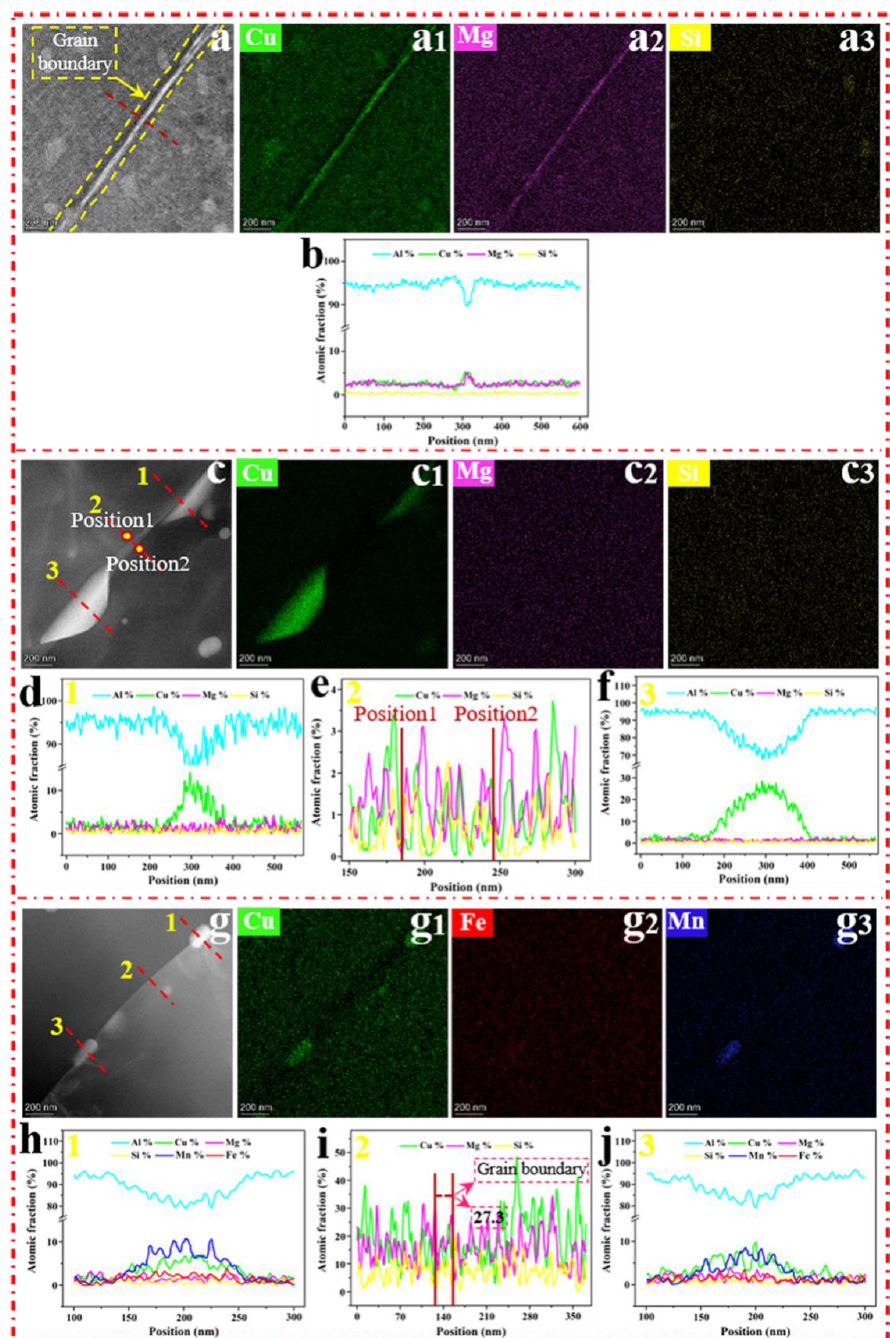
Figure 6. HAADF-STEM images of the grain boundaries without SMGT alloy under 210 °C aging for different times: ( a ) 6 min, ( c ) 27 min, and ( g ) 60 min. The corresponding EDS elemental mappings are shown in ( a 1 – a 3 ), ( c 1 – c 3 ), and ( g 1 – g 3 ), respectively. The HAADF-STEM images show lines across the grain boundary ( a , c , g ). The corresponding EDS line scan curves are displayed in ( b ), ( d,e,f ) and ( h,i,j ) of ( a ), ( c ) and ( g ), respectively.